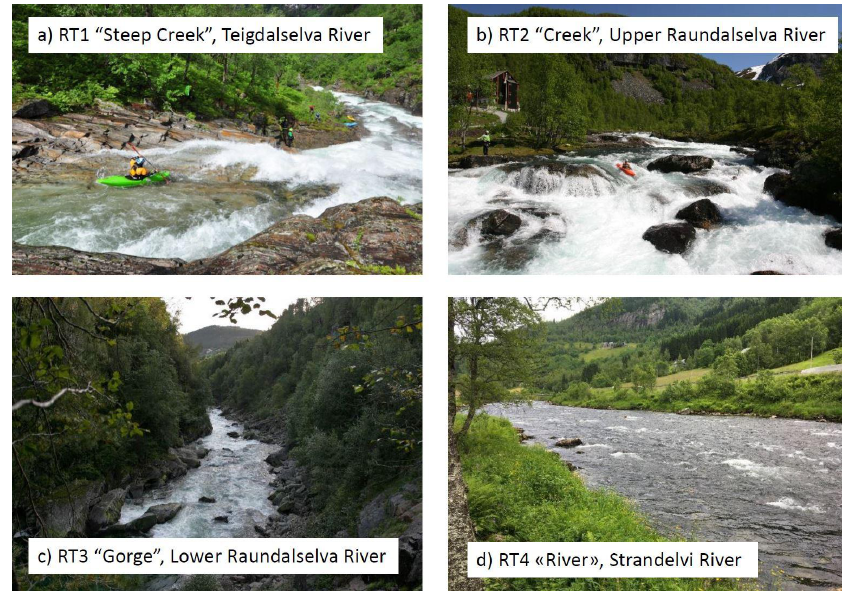
Figure 5. Examples of Norwegian rivers representing the four run types. Photos: ( a ) Steve Arns, ( b , c ) Øystein Bjørke, ( d ) Peggy Zinke.